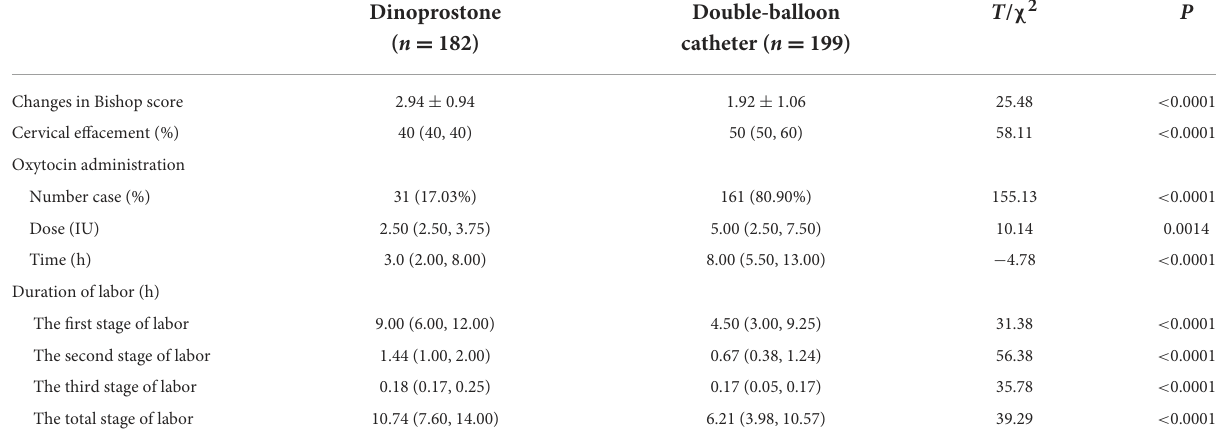
TABLE 2 Cervical ripening